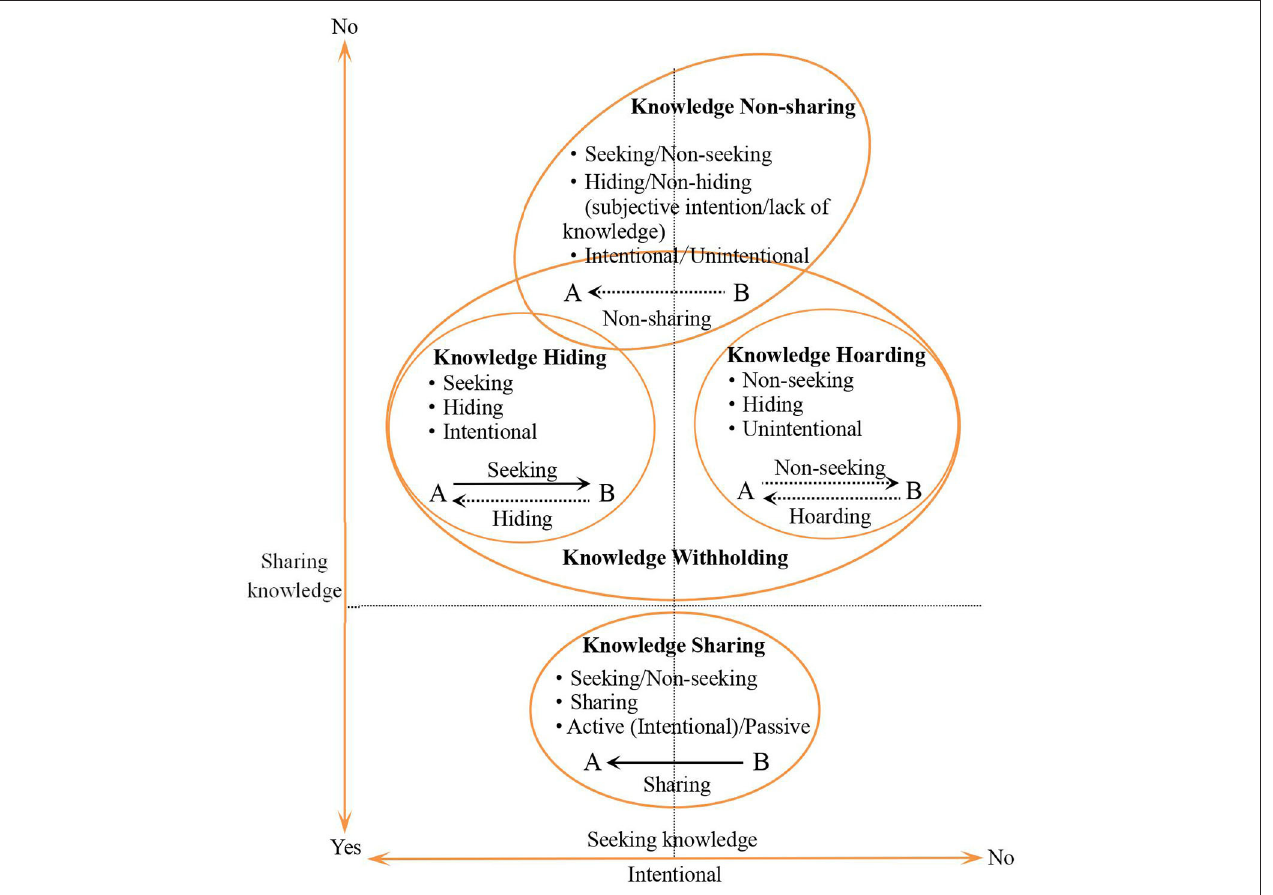
FIGURE 4 | Comparison between knowledge hiding and related concepts. Source: extended and developed from Connelly et al. (2012) and de Garcia et al. (2020).